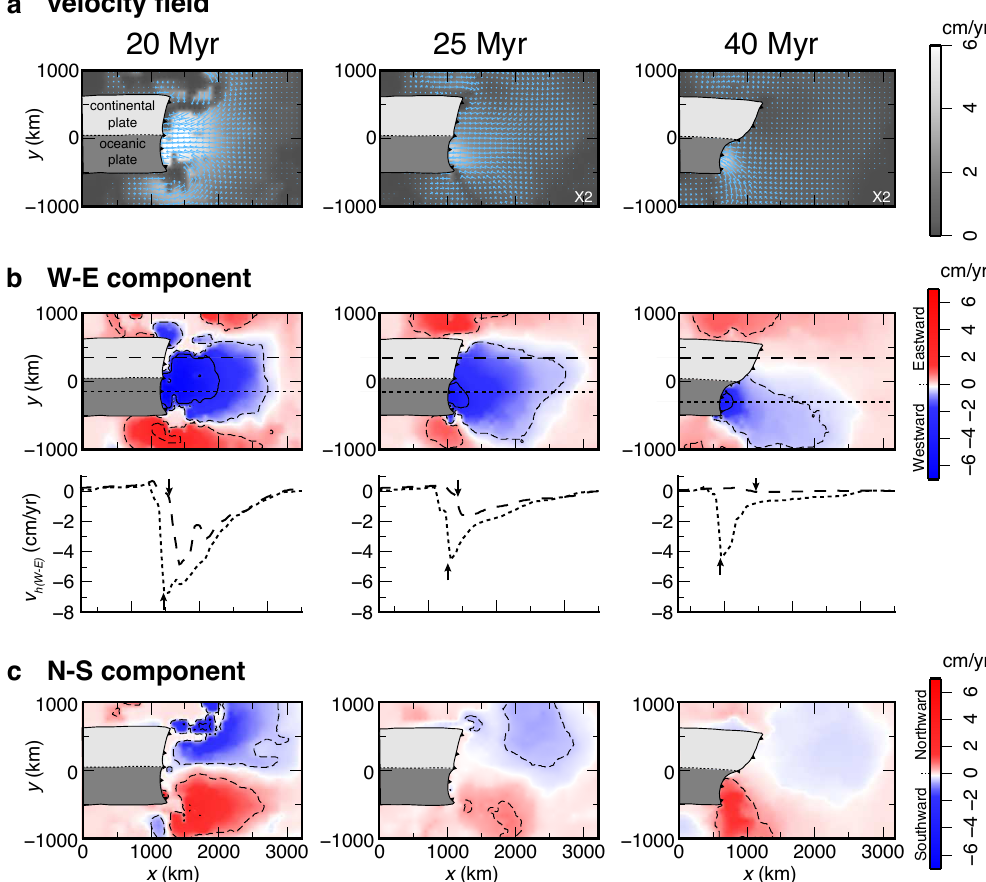
Fig. 6. (a) Velocity vectors and magnitude of the horizontal velocity field for model 11 after 20Myr (left panel), 25Myr (central panel) and 40Myr (right panel) of subduction. Note the changing size of the arrows. (b) Magnitude and along-x profiles of the W–E component of the velocity field. On the maps, black dashed lines underline regions with horizontal mantle flow velocity ( v h ) higher than 0.5cmyr − 1 and black solid lines with v h > 4cmyr − 1 . Positions of continental and oceanic units of the subducting plate are indicated in light grey and dark grey, respectively, and the position of the trench by a black line with triangles. W-directed mantle flow is represented as negative values. Profiles pass through the centre of the continental (dashed line) and oceanic (dotted line) units. Black arrows indicate the position of the trench. (c) Same as (b) but for the N–S component of the velocity field. Southward mantle flow is represented as negative